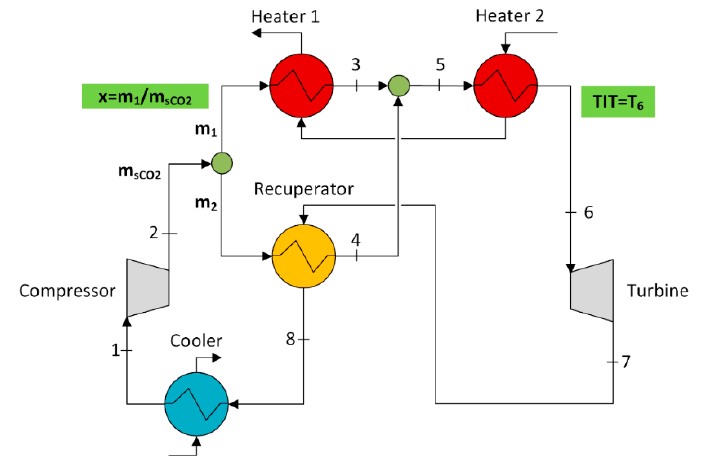
Figure 3. Partial heating s-CO 2 cycle.